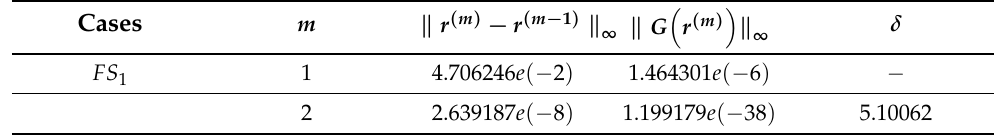
Table 3. Comparison of methods for the load flow